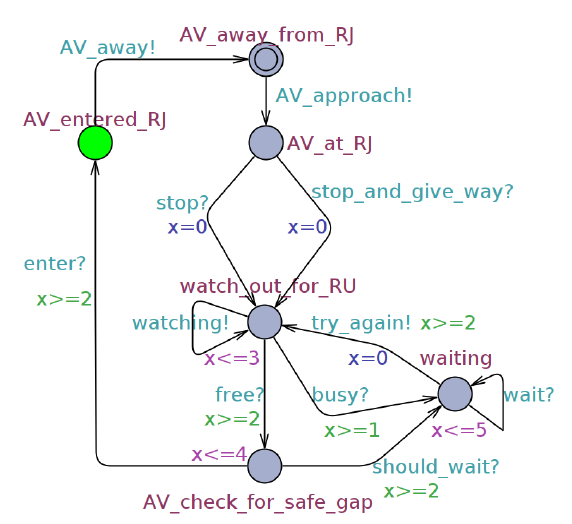
Figure 2. UPPAAL template for AV_agent